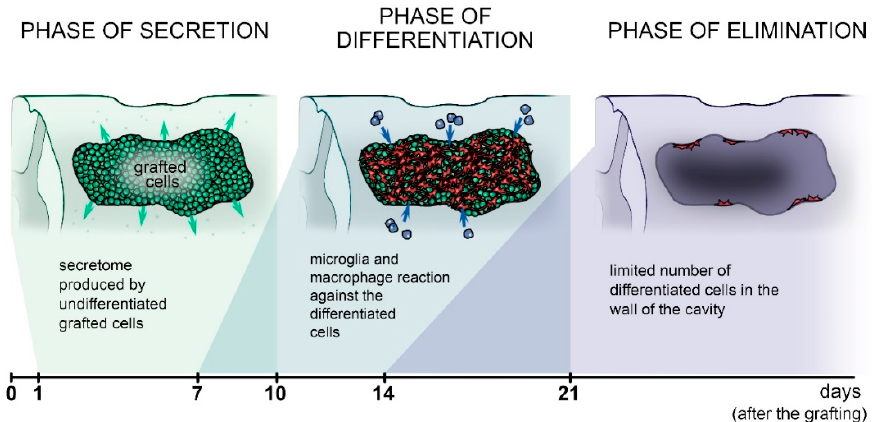
Figure 2. Fate of undifferentiated grafted stem cells in the injured spinal cord. Phase of secretion: Grafted undifferentiated stem cells produce the lesion-induced secretome at least 10 days after grafting. Phase of differentiation: The transplanted stem cells differentiate into neurons and astrocytes, but the microglia/macrophage reaction can be observed against the graft. Phase of elimination: Due to the microglia/macrophage reaction, only a few graft-derived neurons and astrocytes can be detected long-term in the wall of the cavity. Green, undifferentiated transplanted cells; red, graft-derived differentiated cells; blue, microglia/macrophages.